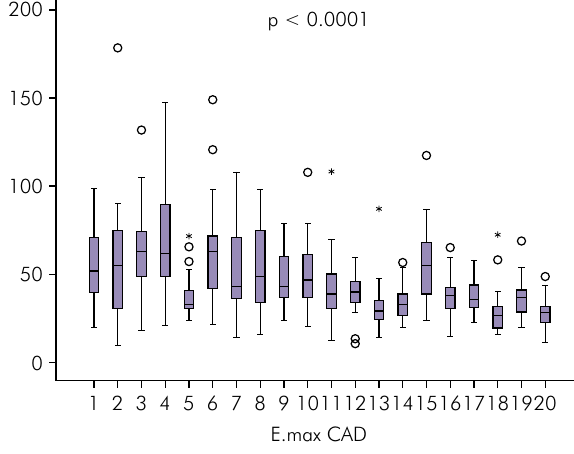
Figure 5. Data distribution for marginal gaps of crowns fabricated with the CAD/CAM technique for each tooth. The horizontal line in the box represents the median value in microns.